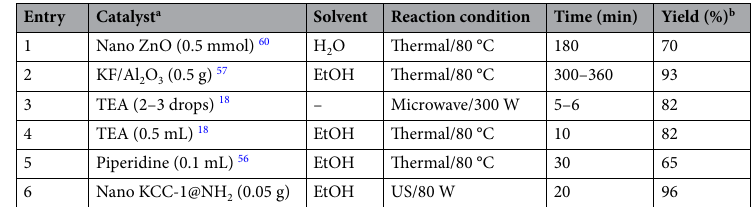
Table 4. Comparison the results of synthesis of 2-Amino-chromens through the Knoevenagel condensation in this research and various reports in the literature. a Literature references. b Isolated